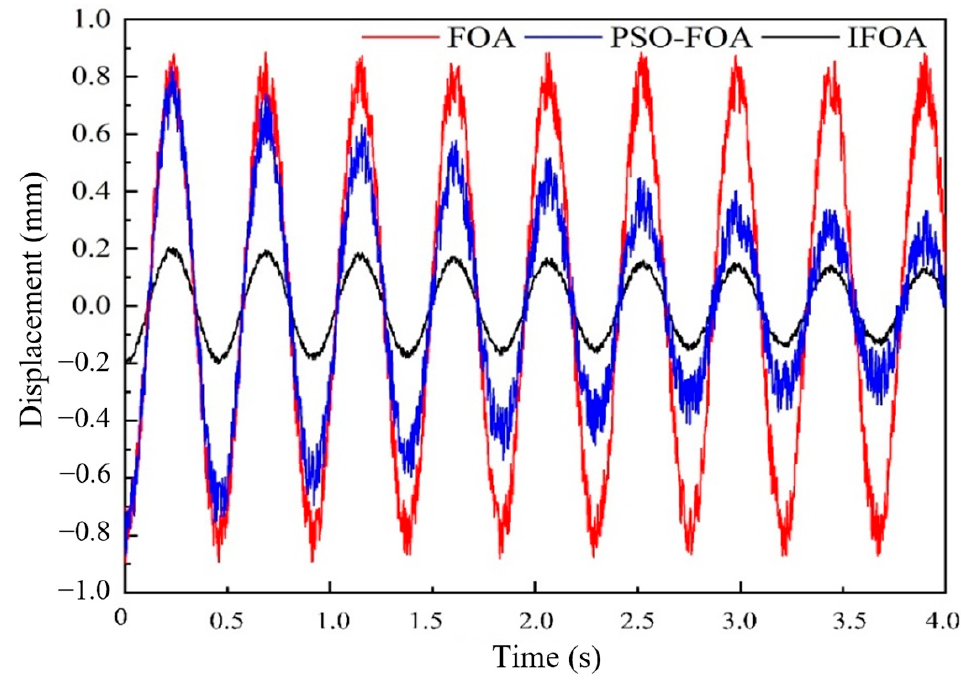
Figure 20. Displacement of frame t at low frequencies.